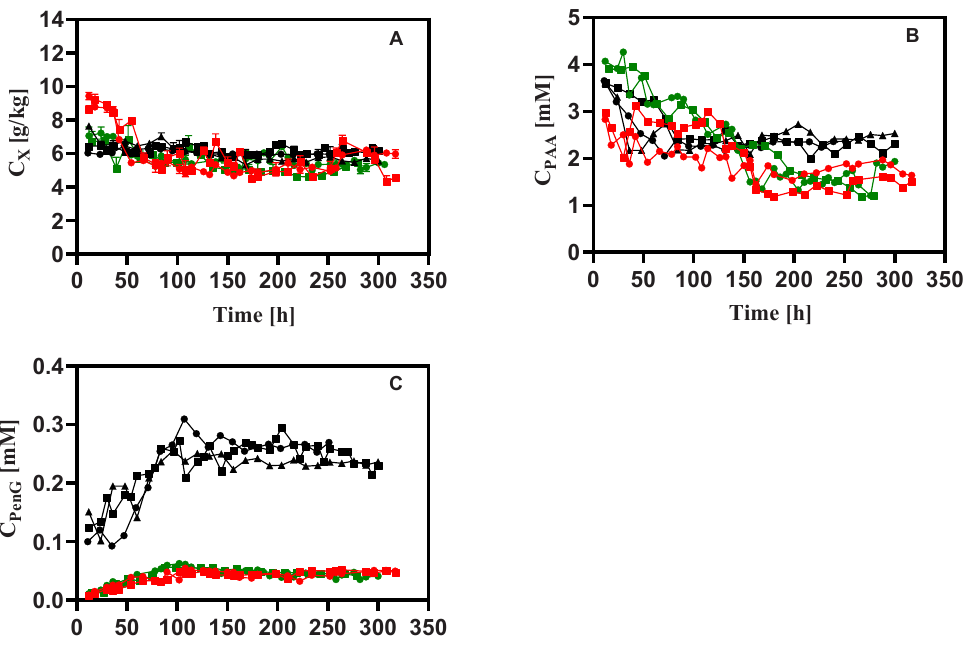
Figure 3. Measured concentrations of ( A ) biomass, ( B ) PAA and ( C ) PenG during rapid feast/famine conditions throughout the chemostat phase. The symbols in black, red and green denote the results obtained from Penicillium chrysogenum Wisconsin 54-1255, Penicillium chrysogenum ∆ tps1 and Penicillium chrysogenum ∆ tps2 , respectively. Time 0 represents the start-up of chemostat cultivation. Abbreviation: PAA, phenylacetic acid; PenG, penicillin-G.